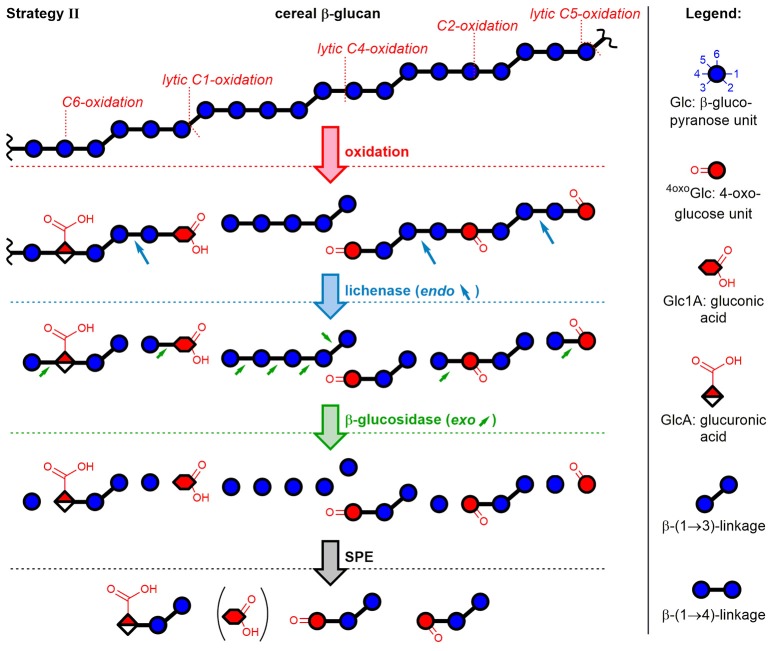
Depiction of mixed-linkage BG and examples of possible oxidation products formed through attack of HO• at different glucose carbons, followed by sample preparation strategy II. Lichenase selectively hydrolyzed as expected the β-(1→4)-linkage of the β-(1→3)-linked glucose units. Digestion by β-glucosidase, an exo-enzyme, was found to successively cleave off glucose units, leaving oxidized oligomers behind, whereas native regions largely hydrolyzed to glucose. Graphitized carbon SPE removed monosaccharides from the reaction mixture (acidic monomers only partially removed). Downstream (reducing) end of oligomers is on the right side (symbolic differentiation as ○–OH omitted for clarity).